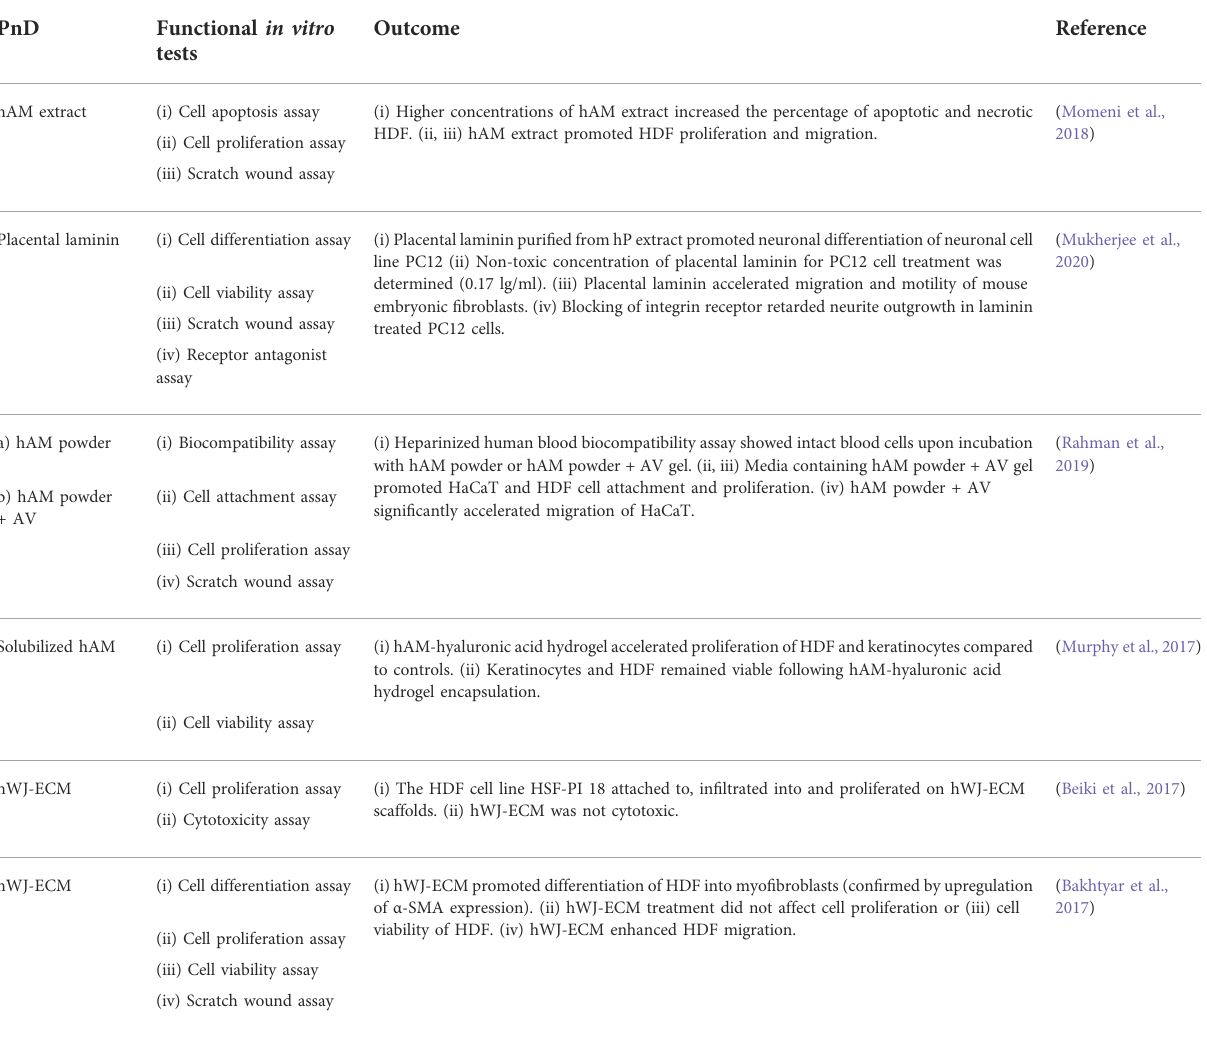
TABLE 5 Functional tests on perinatal tissue extracts alone or combined with conditioned medium (CM). Perinatal tissue